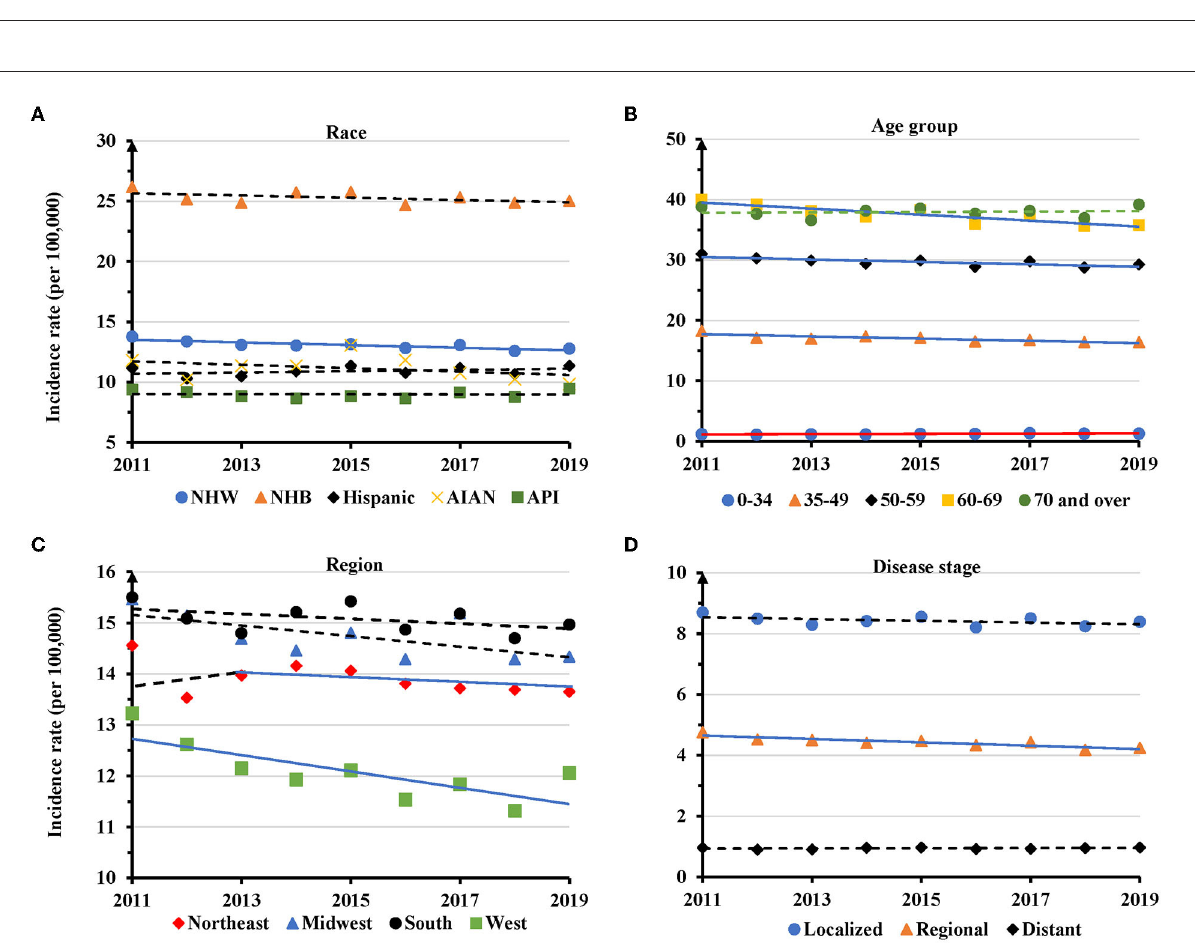
FIGURE2 Temporal changes in age adjusted incidence rates of TNBC by race, age group, region and disease stage during 2011–2019. (A) Age group. (B) Race. (C) Region. (D) Disease stage. Solid lines indicate a significant annual percentage change (APC) of age adjusted incidence rate. Dashed lines show no significant